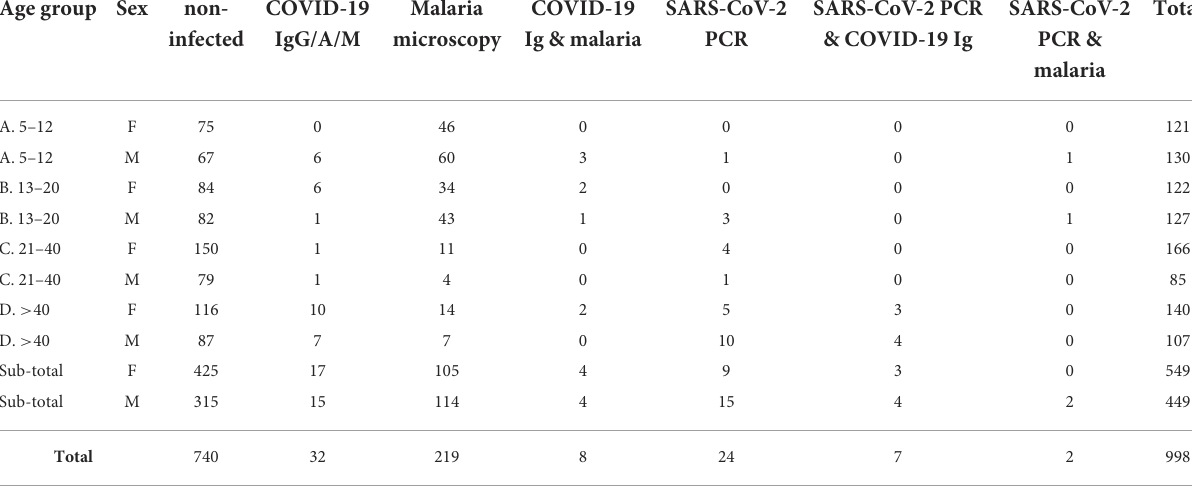
TABLE 1 Distribution of positive cases in the whole sampled population by age classes and gender. Age group Sex